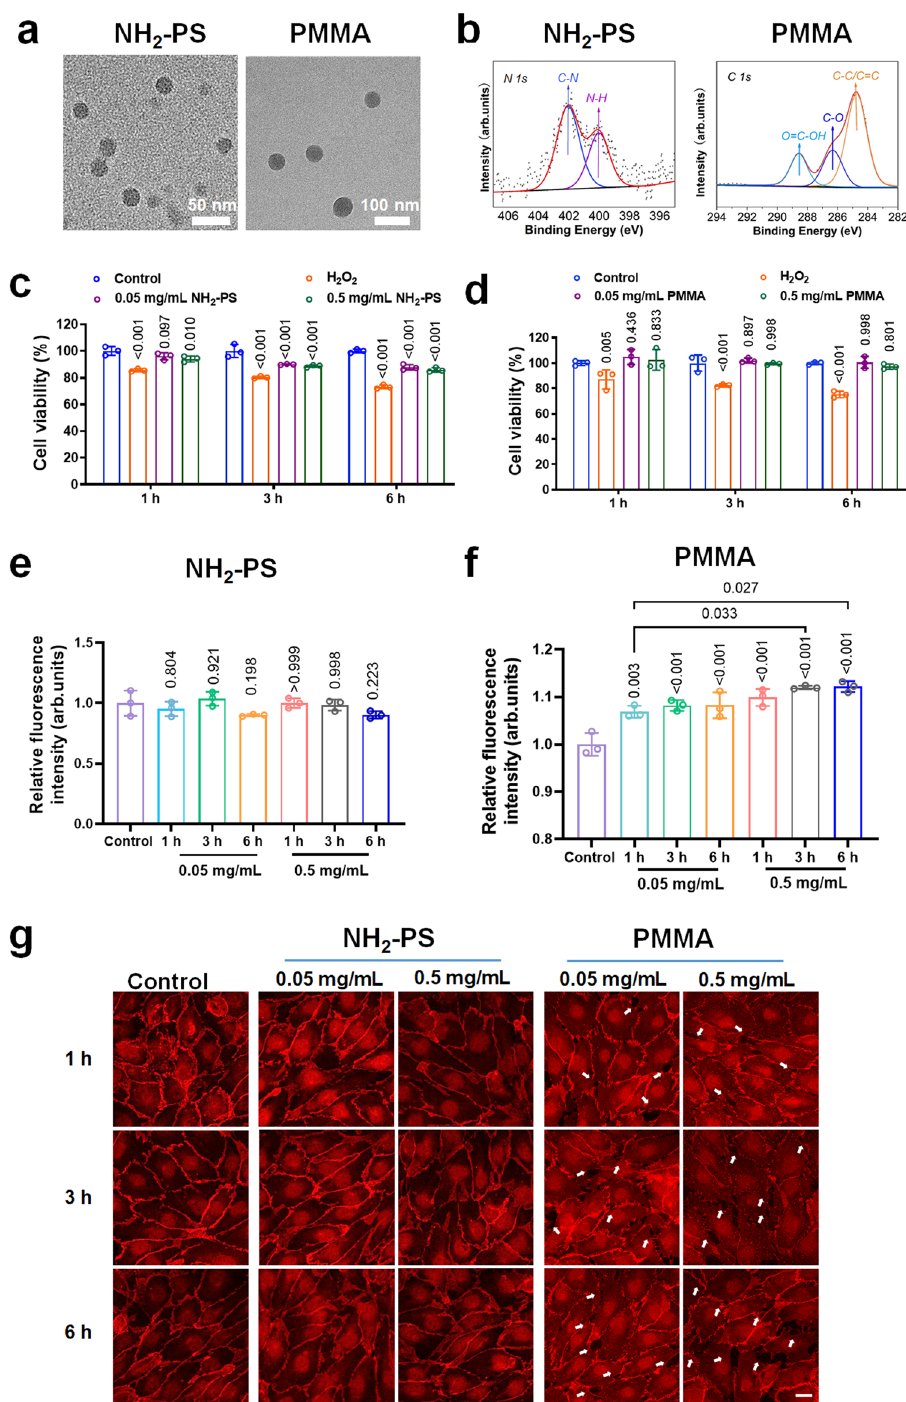
Fig. 3 | Characterisations of NH2-PS and PMMA nanoplastics and their NanoEL competence with HUVECs. a TEM imaging of NH 2 -PS and PMMA nanoplastics in H 2 O (n =3 independent samples). b Functional groups of NH 2 -PS and PMMA nanoplastics were determined by XPS analysis. The major peaks for NH 2 -PS at 402.06 and 400.02eV were referable to C – N and N – H bonding, respectively. The dominant peak for PMMA at 284.74eV arose from C – C or C=C bonding, and the peaks at286.33eV and 288.57eV can be attributed to C – O, and O=C – OH bonding, respectively. c , d Cell viability of NH 2 -PS and PMMA nanoplastics at 0.05 and 0.5mg/mL, measured by a CCK8 assay at different times (1, 3, and 6h). H 2 O 2 (200 μ M) was used as positive control. Data are expressed as means±SD ( n =3 biologically independent experiments).Statisticalanalysiswas performedthrough one-way ANOVA followed by Tukey ’ s multiple comparison tests. The derived P